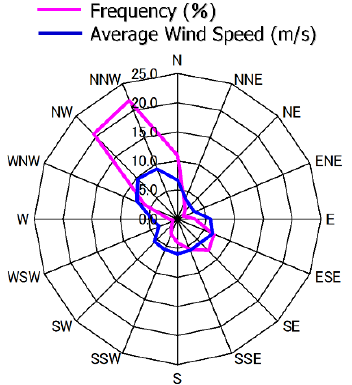
Figure 3. Wind rose diagram from April 2016 to March 2017 based on wind speed and wind direction sensors of the No. 2 wind turbine.